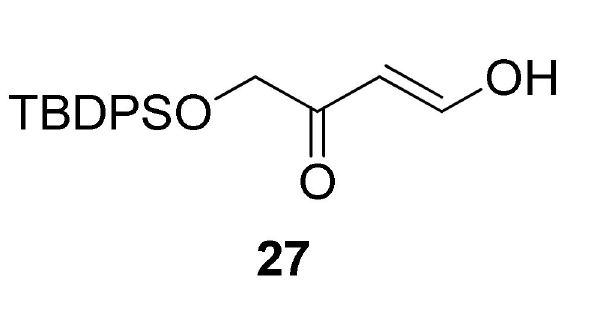
Figure 1. By-product 27 from the reaction of the Weinreb amide 18 with lithium trimethylsilylacety- lene (Scheme